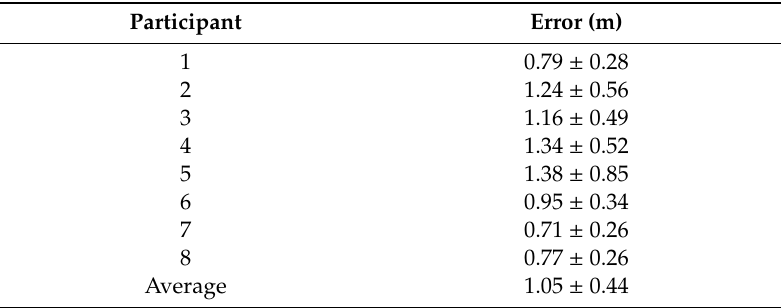
Figure 7 contains the 10 reconstructed trajectories for each participant. The trajectories were aligned with the map only at the beginning of the first activity taking as a reference to the first participant’s strides while descending the